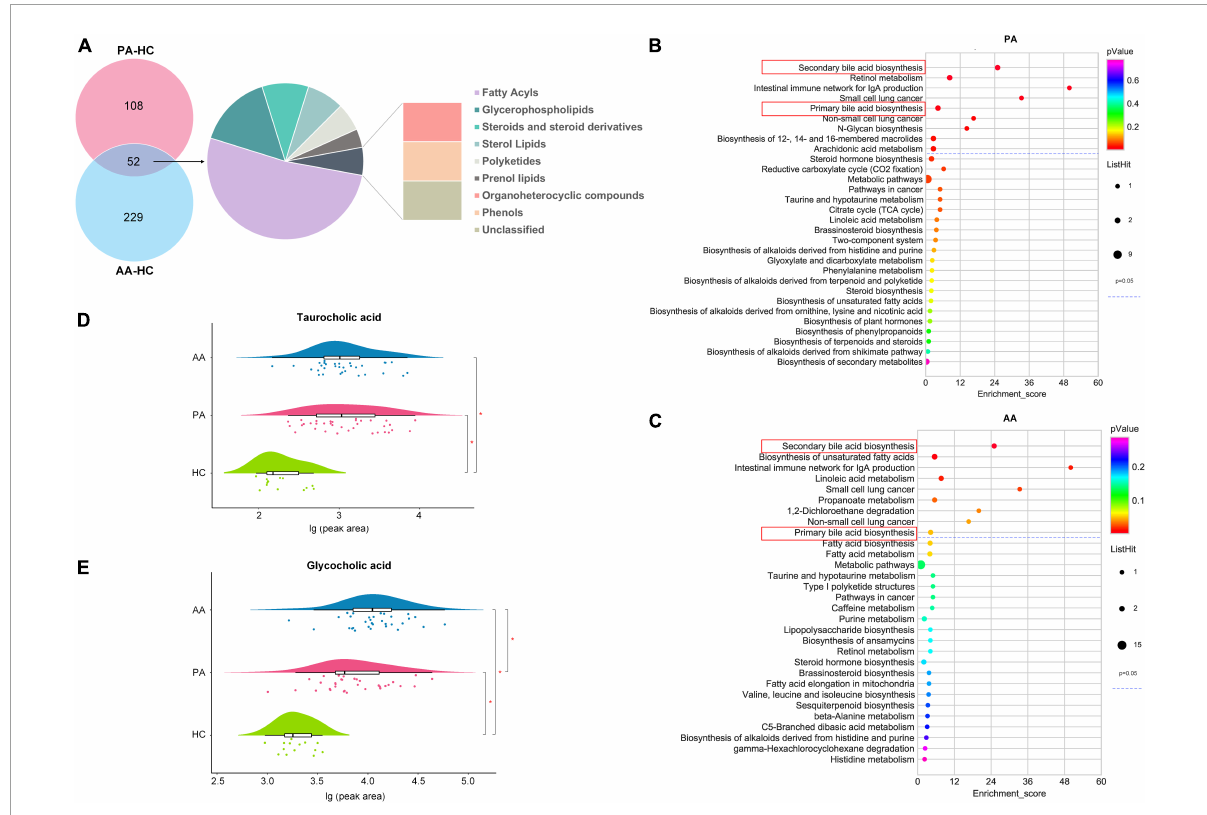
FIGURE2 Differential metabolites and metabolic pathway enrichment via untargeted metabolomics analysis. (A) Shows the classes of differentially accumulated metabolites between PA and AA and HC. (B,C) Show the concentrations of the taurocholic acid and glycocholic acid among PA, AA, and HC, respectively. (D,E) Show the enrichment of PA and AA metabolic pathways, respectively. PA, patients in the acute stage; AA, asymptomatic cases in the acute stage; HC, healthy